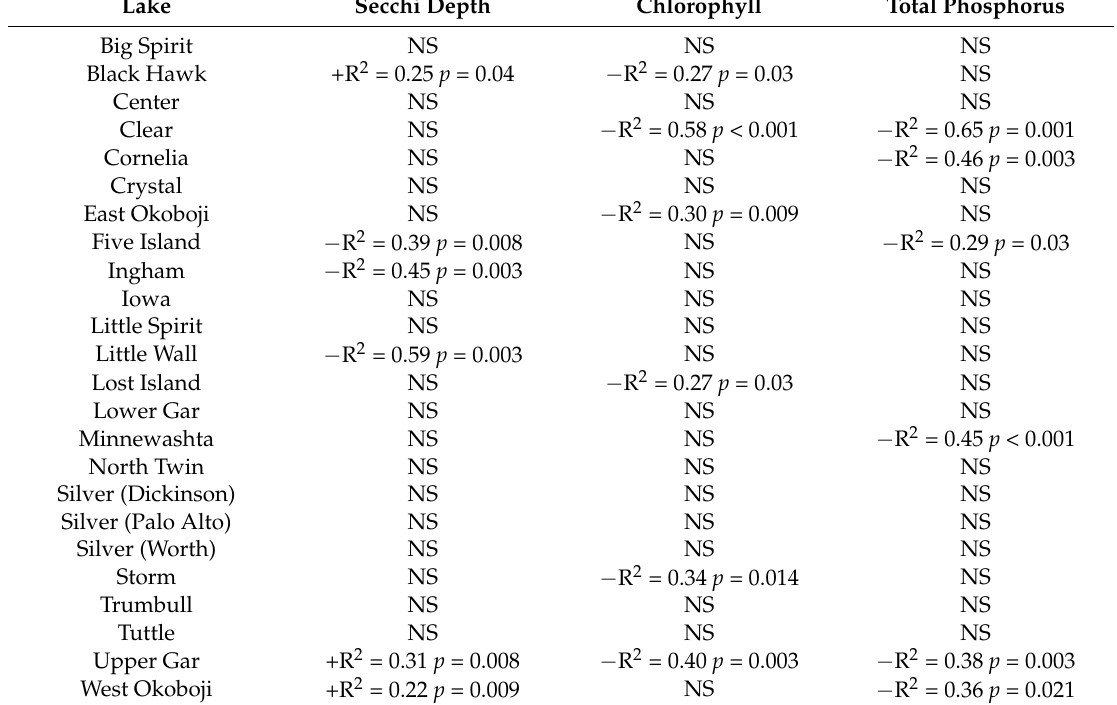
Table 2. Results of regressions of Secchi depths, chlorophylls, and total phosphorus versus time for 24 Iowa lakes as indicated by direction of relation (+ or − ), R 2 -value, and probability. NS indicates not statistically significant with p <